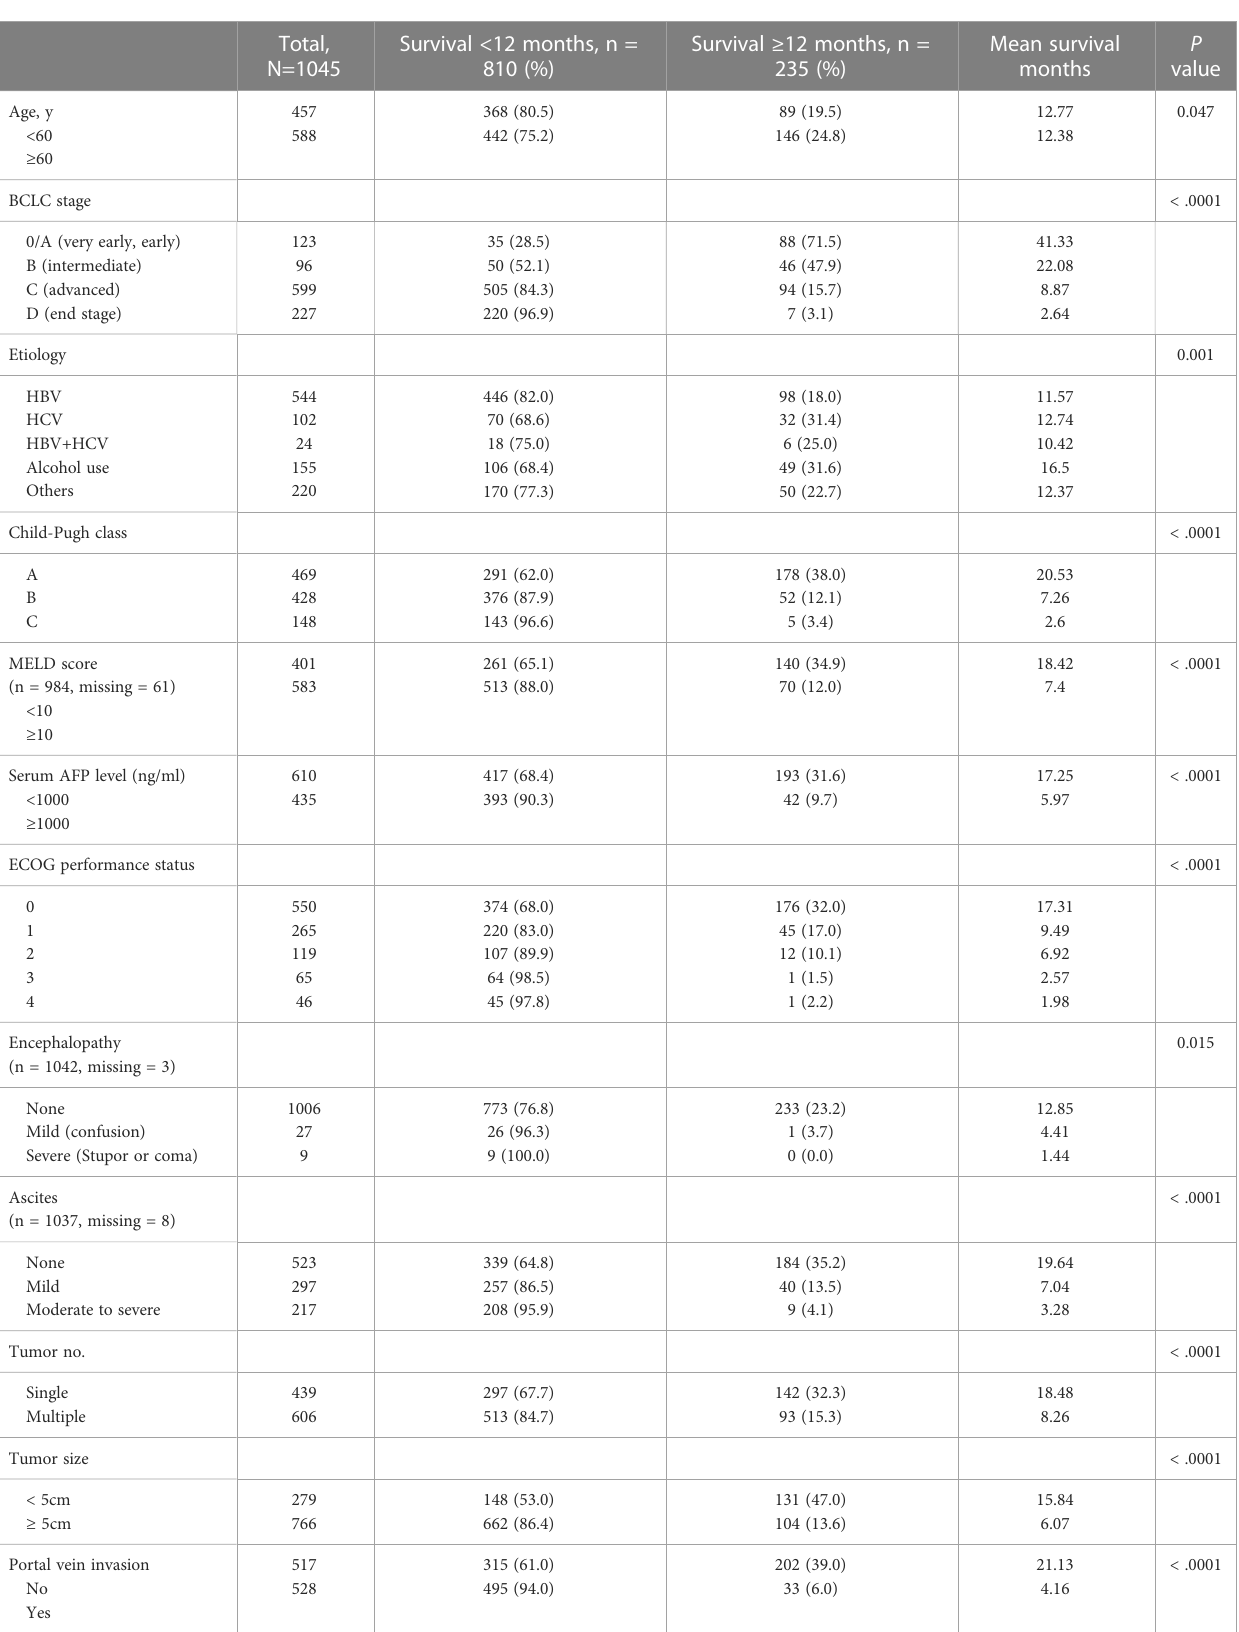
TABLE 2 Potential determinants of survival among 1045 patients with untreated